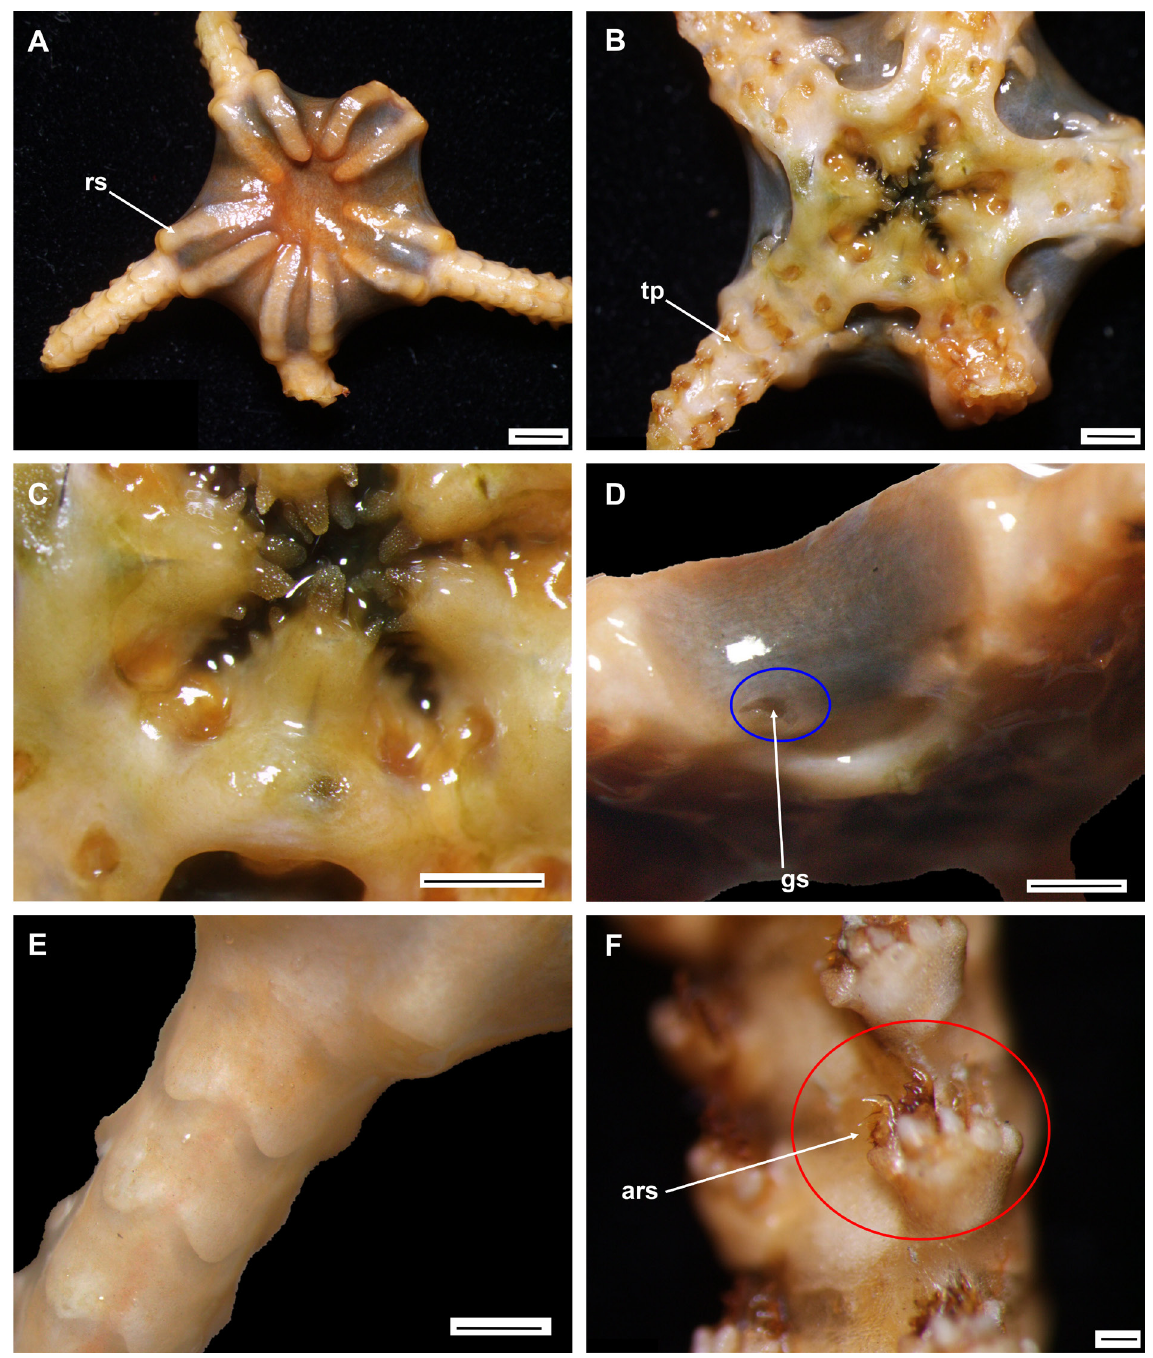
Fig. 2. Asteronyx loveni Müller & Troschel, 1842 (IDSSE EEB-SW0002). A . Dorsal disc. B . Ventral disc. C . Oral frame. D . Genital slit. E . Dorsal arm. F . Arm spines. Abbreviations: ars = arm spines; gs = genital slit; rs = radial shield; tp = tentacle pore. Scale bars: A–B = 2 mm; C–E = 1 mm; F = 200